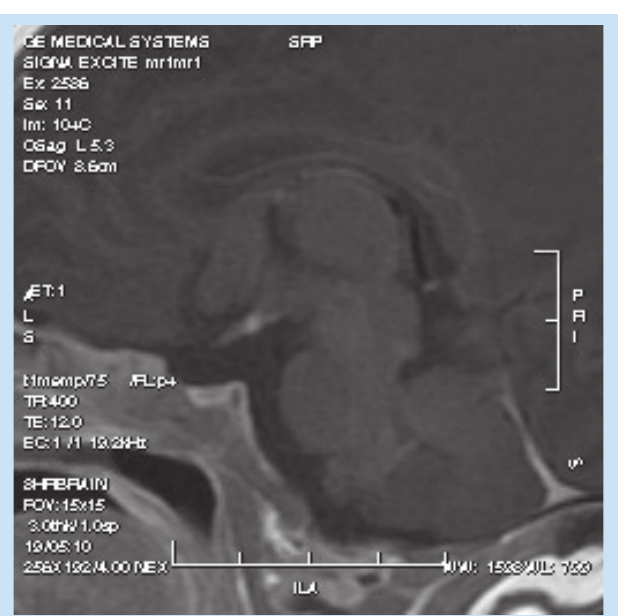
Fig. 3a. A sagittal T1W MRI scan demonstrating the not very hyperintense posterior pituitary gland outside the sella and along the pathway of the stalk, non-visualisation of the adenohypophsis, an absent corpus callosum, promi- nence of the anterior commisure, and a tiny cyst in the pineal.